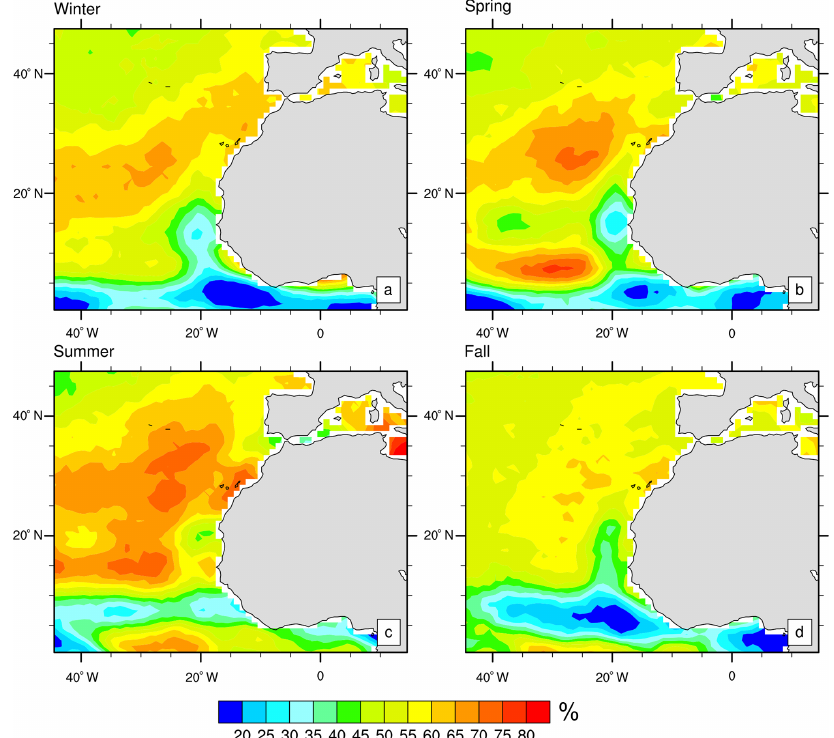
Figure 2. Percent of days from 2004 to 2012 in which marine stratocumulus clouds are found following Medeiros and Stevens (2011) in (a) winter, (b) spring, (c) summer, and (d)